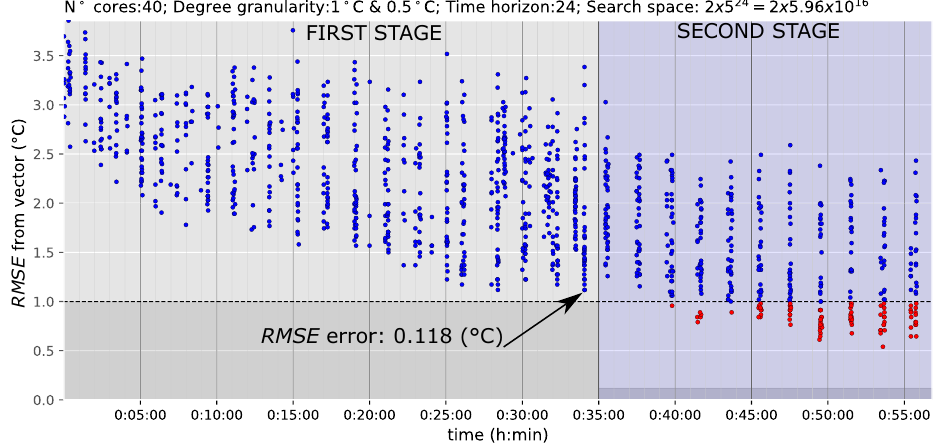
Figure 9. MPC results using two stages to obtain the MPC vector (24 h).